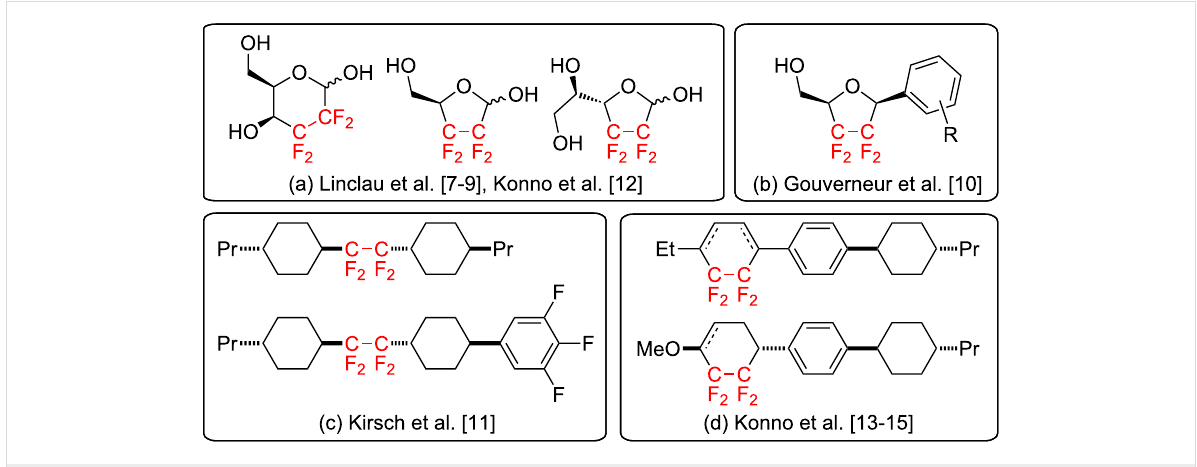
Figure 1: Functional molecules with CF 2 CF 2